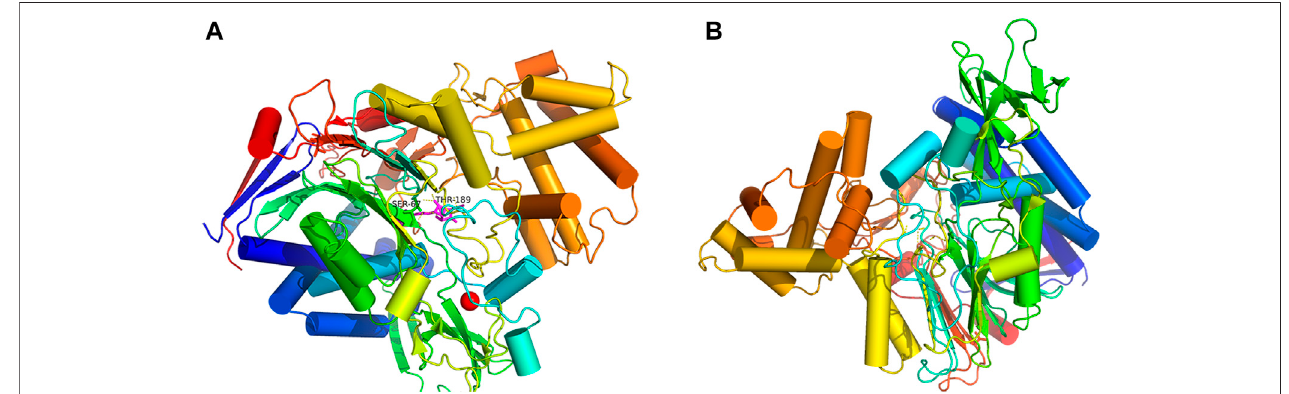
FIGURE 4 | Orientation con fi rmation of PGA (A) , and molecular docking mode of penicillin K and PGA (B) .